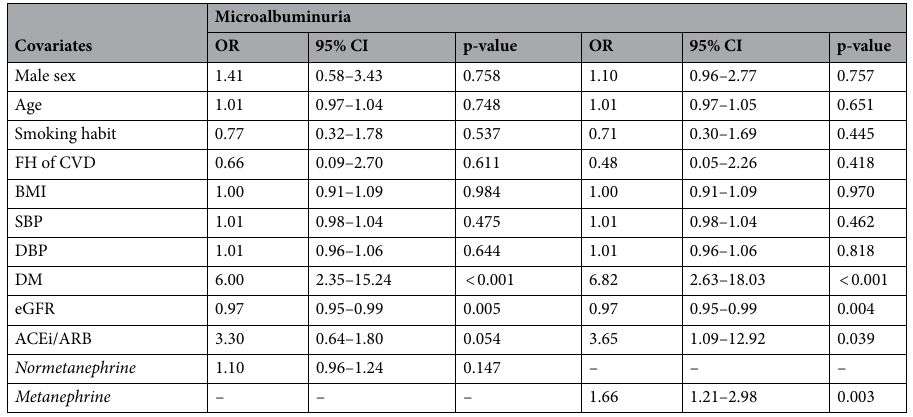
Table 7. Logistic regression analysis on the association of covariates with presence of microalbuminuria (ORs of metanephrine are calculated for a unit of increase of 100 μg/day). ACEi/ARB, angiotensin converting enzyme inhibitors or angiotensin II receptor blockers; BMI, body mass index; CI, confidence interval; CVD, cardiovascular disease; DBP, diastolic blood pressure; DM, diabetes mellitus; eGFR, estimated glomerular filtration rate; FH, family history; OR, odds ratio; SBP, systolic blood pressure.